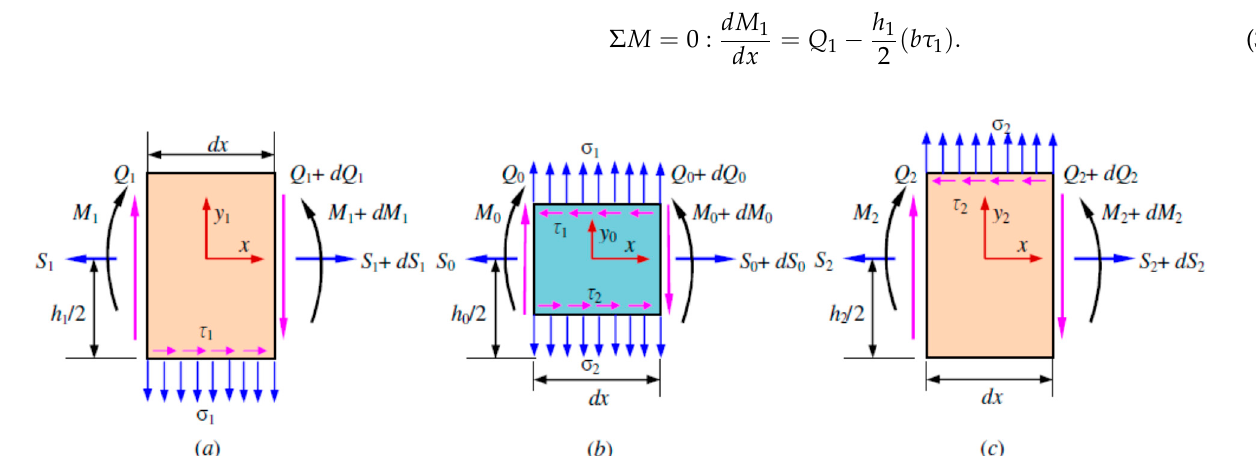
Figure 2. Free-body diagrams of the three-layered segment of an adhesively bonded joint (ABJ): ( a ) the upper adherend layer, ( b ) the adhesive layer, and ( c ) the lower adherend layer.